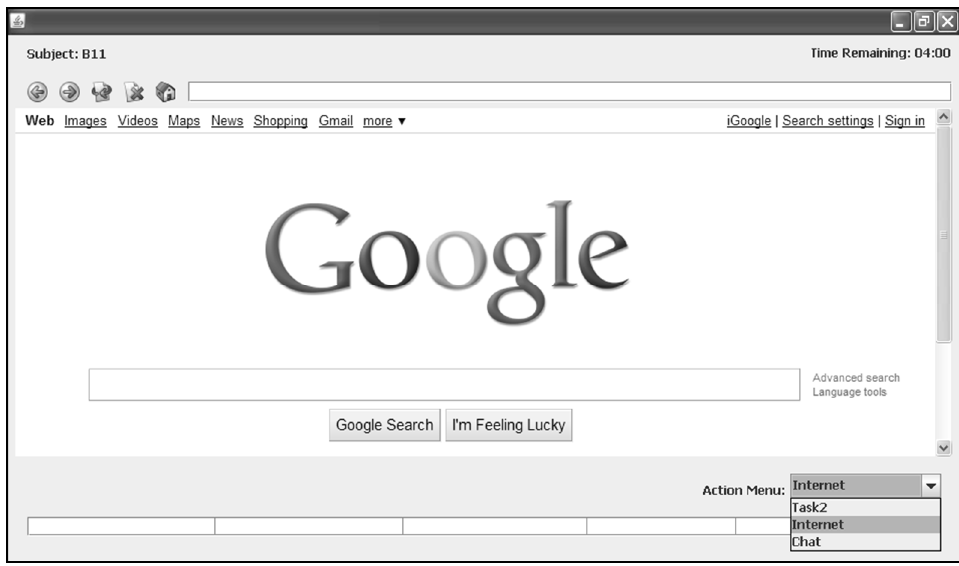
Figure 2. Embedded Internet